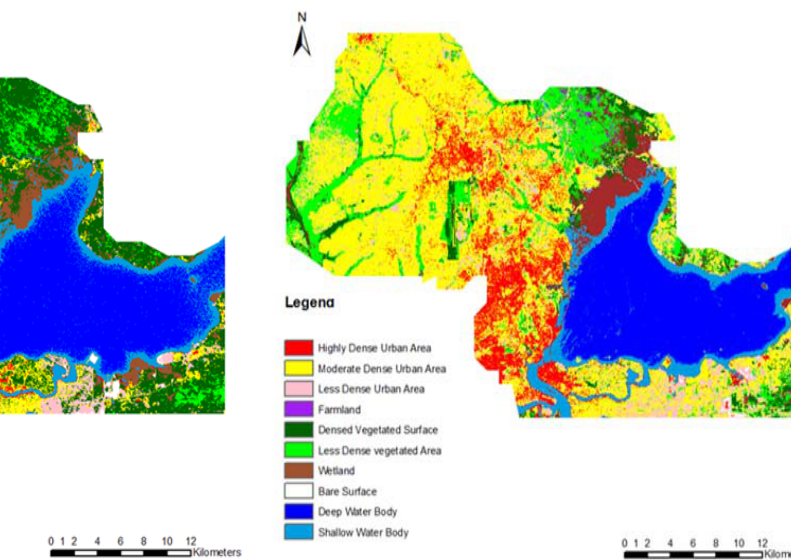
Fig. 2: Land cover classification for the nine local government areas (2002)